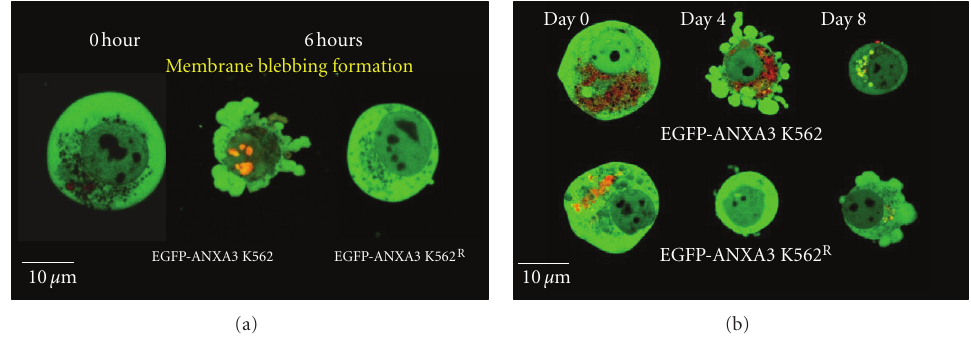
Figure 1: Common morphology between K562 cells after MnCl 2 and haemin treatments. ((a) and (b)) K562 and K562 R cells expressing EGFP-ANXA3 were observed under CLSM at several time points after MnCl 2 or haemin induction ( n = 6).